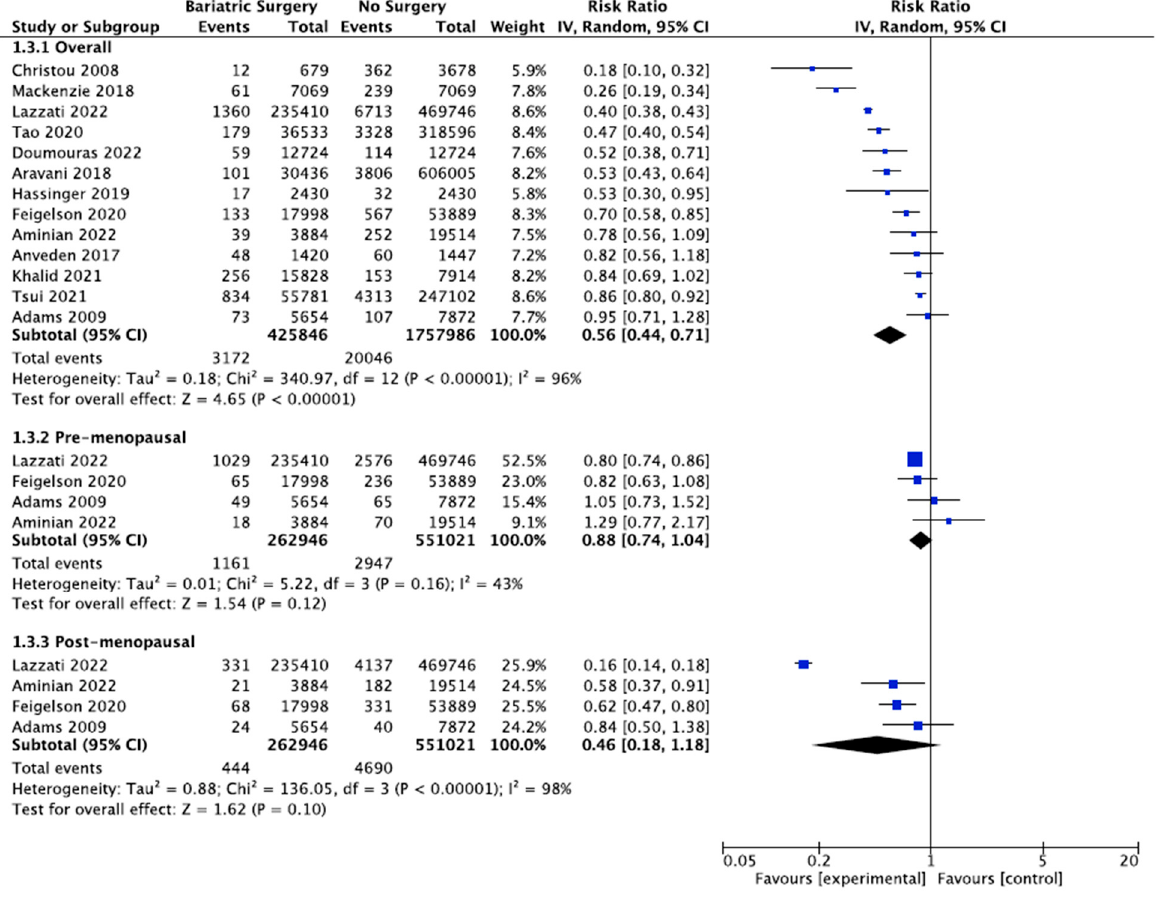
Eight studies reported on endometrial cancer incidence, with 346,430 female patients in the bariatric surgery cohort compared to 1,075,024 female patients in the control group. Bariatric surgery was associated with a signi fi cant reduction in the incidence of endome- trial cancer (RR 0.38, 95% CI 0.26–0.55, p < 0.00001). There was statistically signi fi cant het- erogeneity across the studies (Chi 2 = 109.50, p <0.00001, I 2 = 94%) (Figure 7).